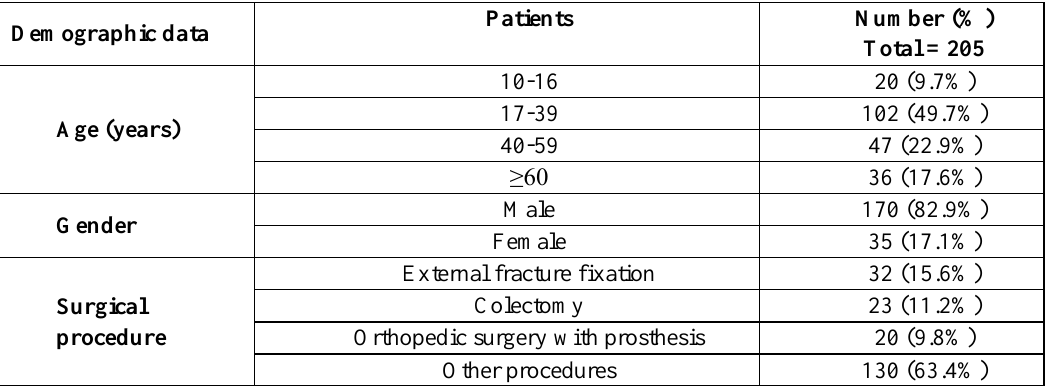
Table 1. Demographic data of the studied